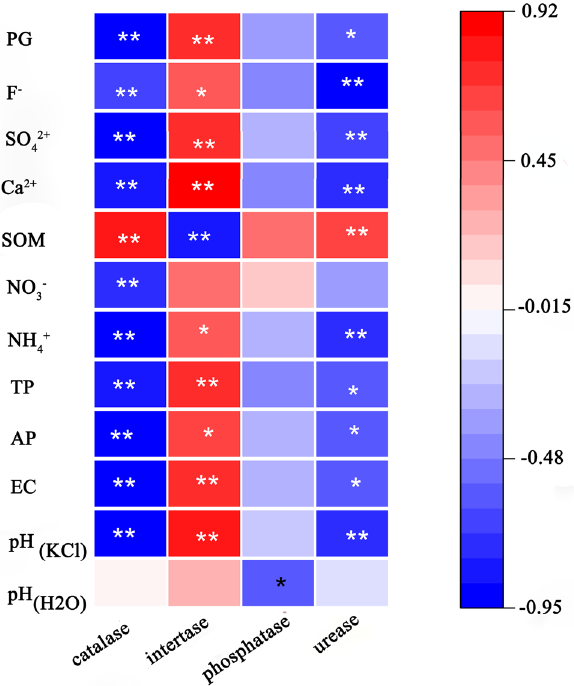
Figure 3. Correlation between soil enzyme activity and soil characteristics. * P < 0.05; ** P < 0.01.